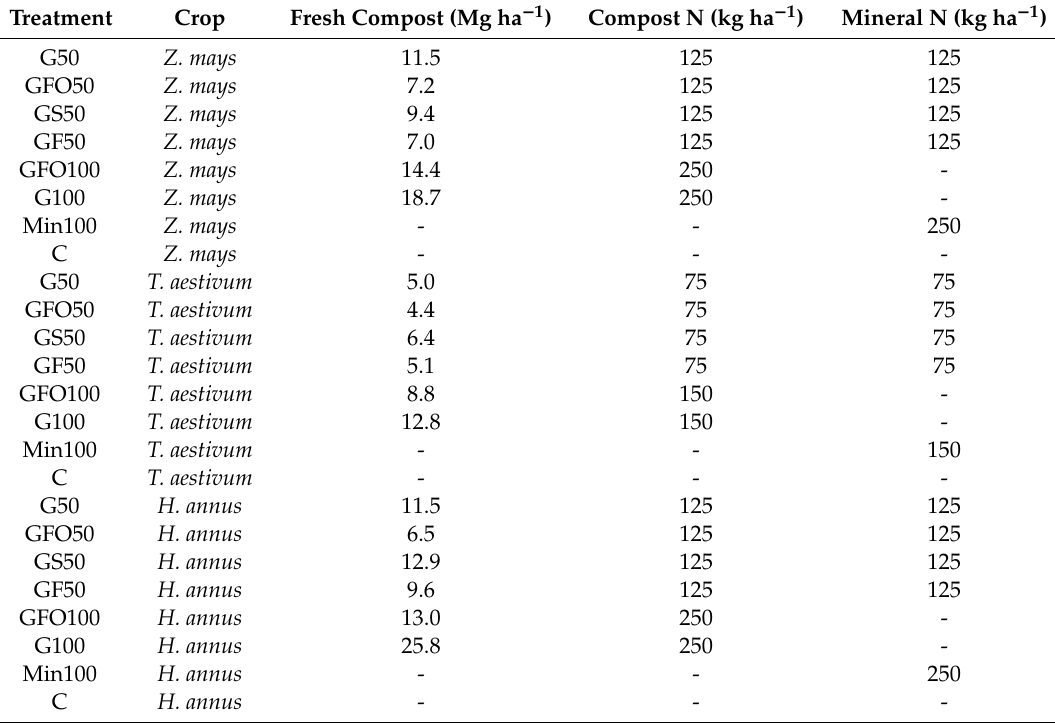
Table 4. Fertilization schemes adopted for all studied